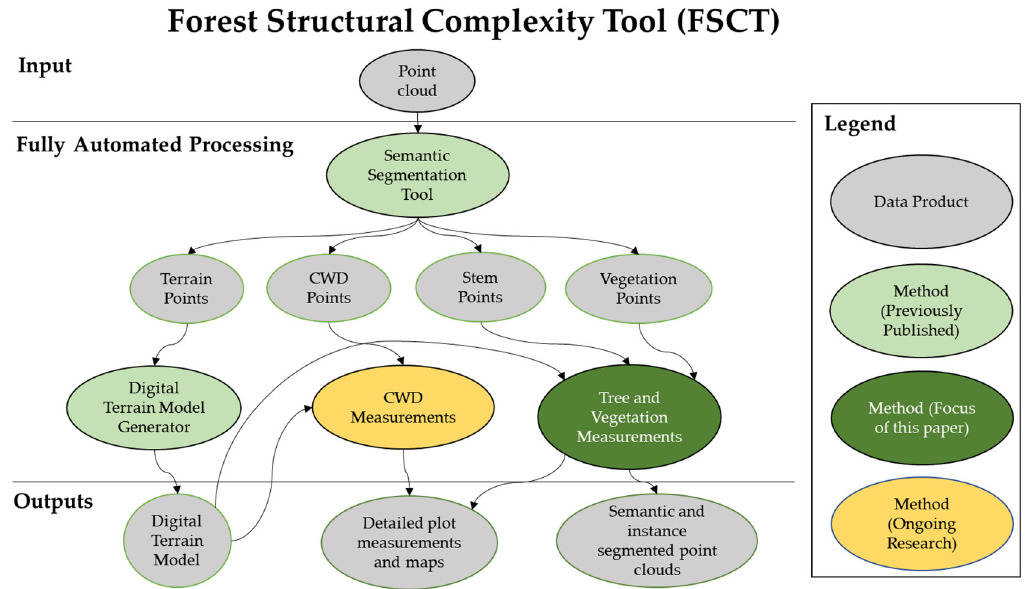
Figure 1. Schematic diagram describing how this research, which focuses on tree and vegetation measurement extraction, fits into our larger goal of creating a fully automated forest point cloud measurement tool. The “previously published” research refers to our previous paper on this project, which focused on the semantic segmentation of complex forest point clouds [58]. This open source tool is available here: https://github.com/SKrisanski/FSCT (accessed on 19 November